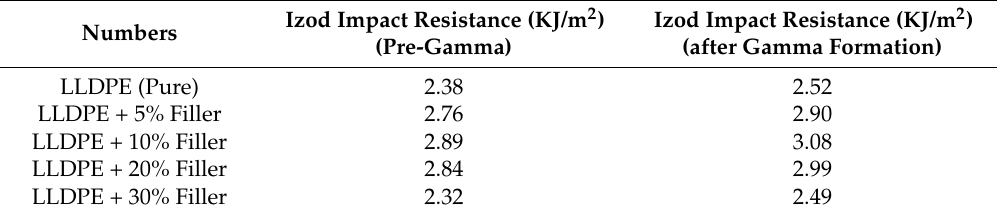
Table 7. Comparative presentation of Izod impact strength findings for polyethylene matrix samples before and after